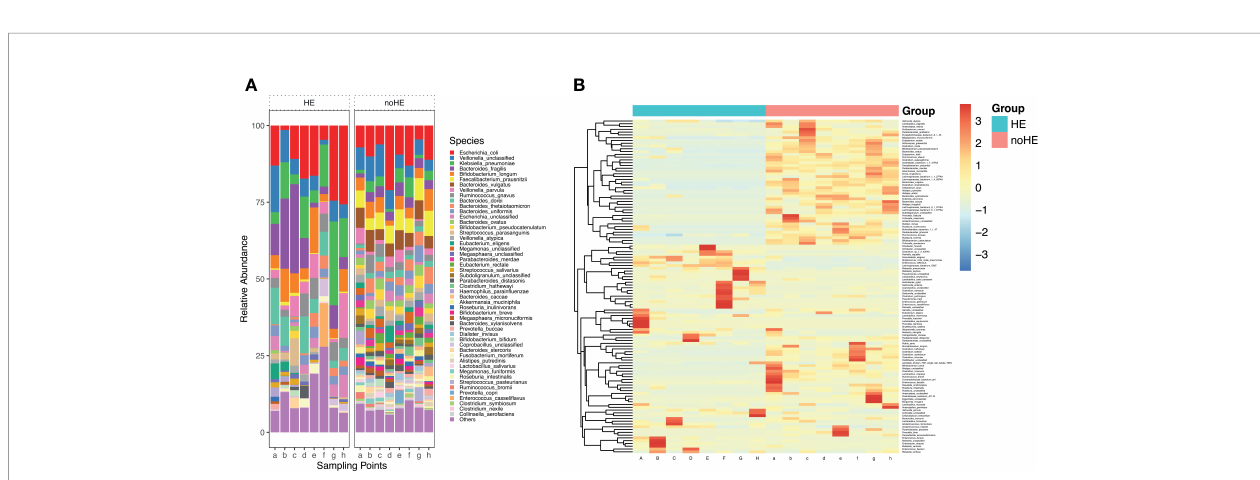
FIGURE 2 | Changes in gut microbiota (at a species level) in patients over time. Horizontal coordinates denote sampling time points; a – h represent Day 1, Week 1, Week 2, Week 4, Week 6, Week 8, Week 10, and Week 12, respectively. Vertical coordinates denote the relative abundance of the species (%).